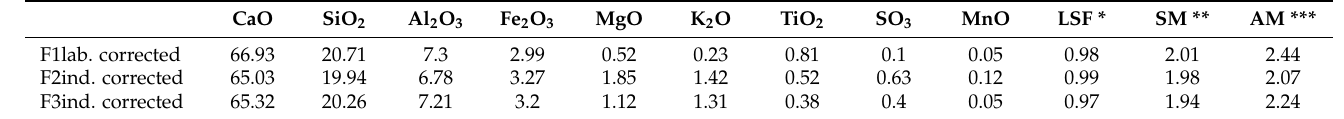
*: Lime saturation factor; **: Silica Modulus, ***: Alumina Modulus.